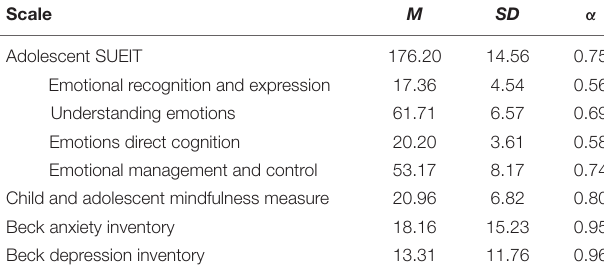
TABLE 1 | Descriptive statistics and reliability statistics of